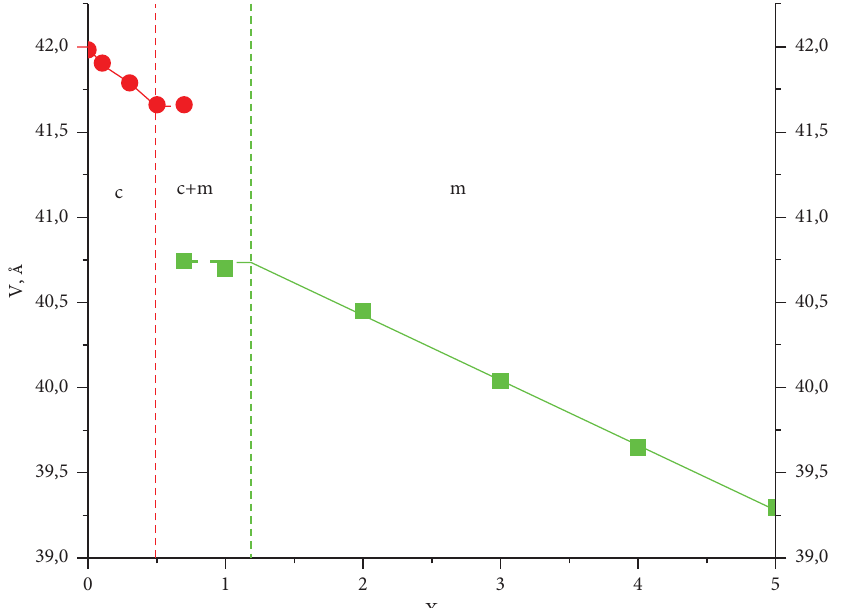
5 − x Tb x Mo 3 O 16+ δ series content.